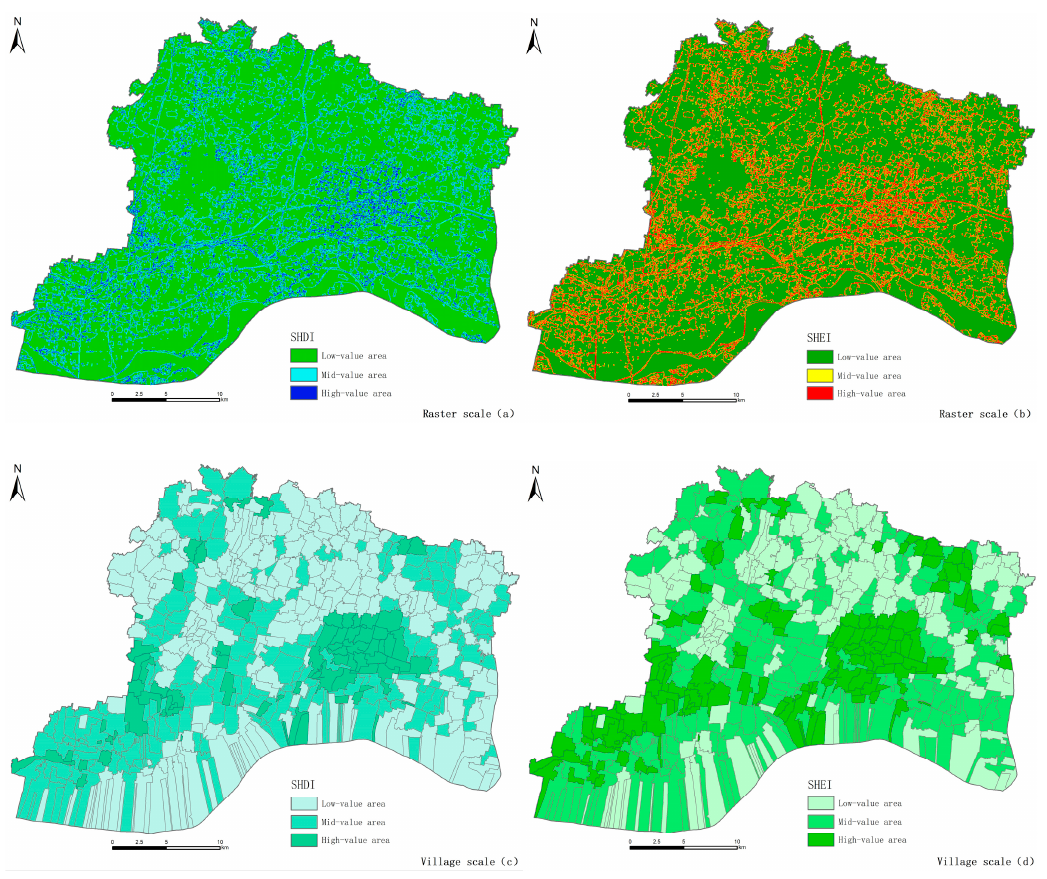
Figure 2. Spatial landscape pattern analysis in Yuanyang County.